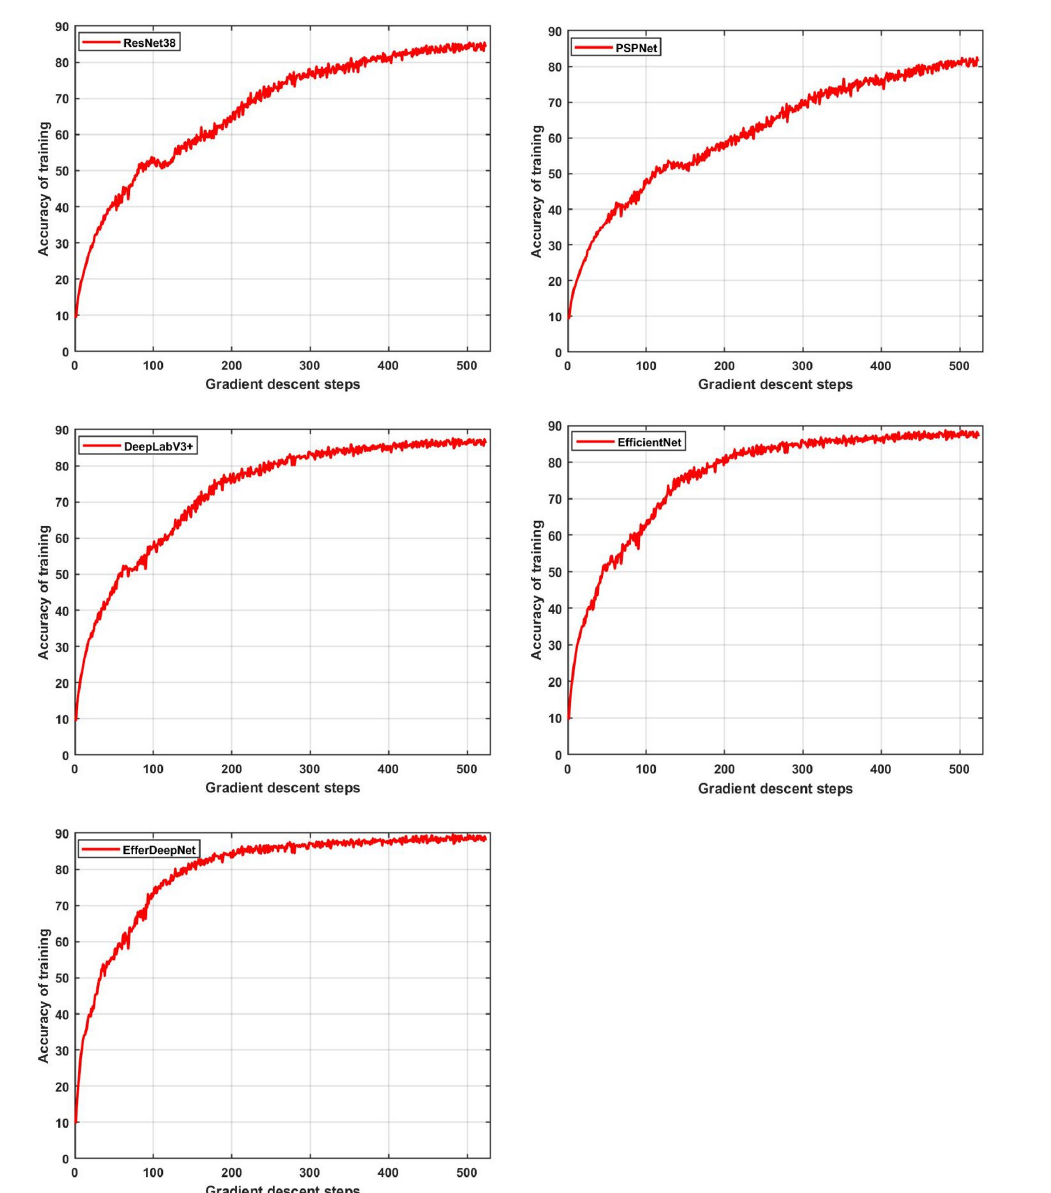
Figure 12. Accuracy comparison of different